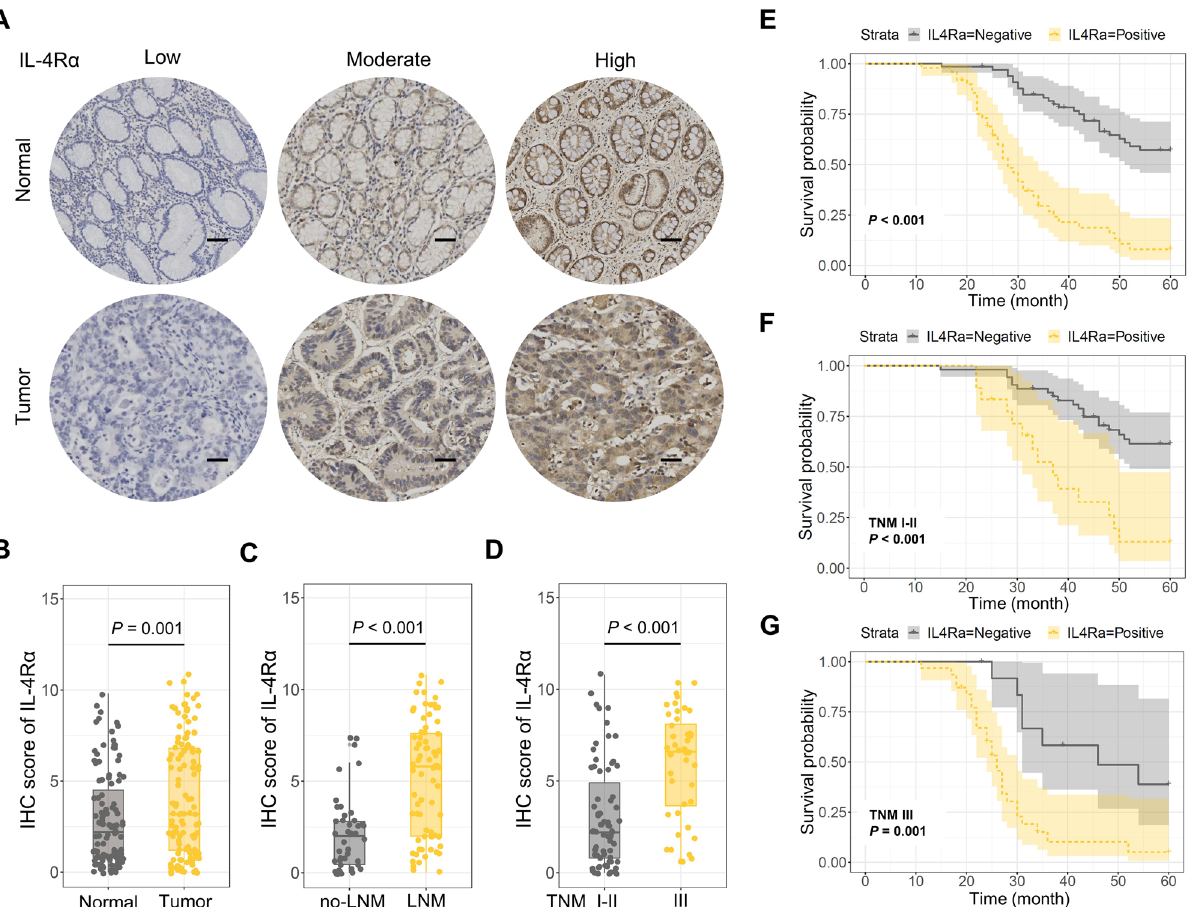
Figure 2. IL-4Rα expression and Kaplan–Meier analysis of 115 GC patients. ( A ) IL-4Rα expression using IHC staining in 115 GC and para-cancer tissues (scale bar 100um). ( B – D ) The IHC score of IL-4Rα in ( B ) GC and para-cancer tissues, ( C ) GC with or without lymph node metastasis, ( D ) GC with TNM I–II or TNM III staging. ( E – G ) Kaplan–Meier analysis of IL-4Rα positive vs. IL-4Rα negative in ( E ) 115 GC patients, ( F ) GC patients with TMN I–II staging, and ( G ) GC patients with TMN III